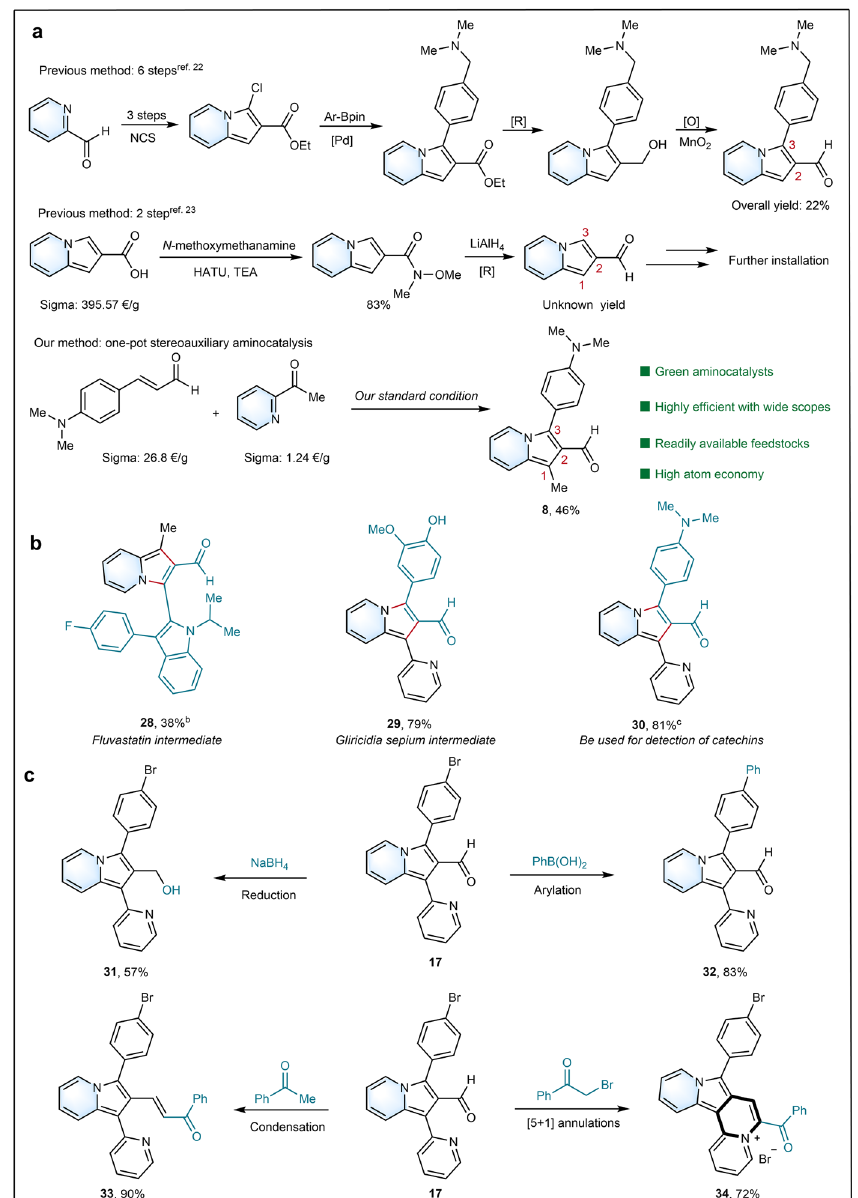
Fig. 4 Synthetic applications. a Representative previous methods for 3-dimethylaminoindolizine-2-aldehyde. b Late-stage selective modi fi cations of bioactive molecules and drugs. c Late-stage diversi fi cation. a Yields are those of isolated products. b Reaction for 42 h in AcOH : CF 3 CH 2 OH (0.45